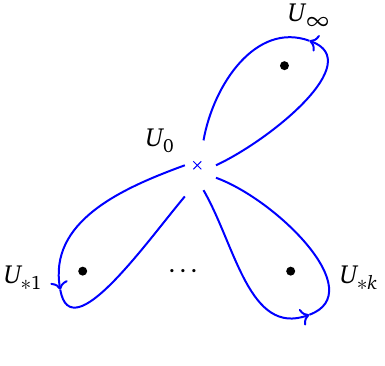
Figure 1: Paths γ generating the fundamental group of the U -plane. The path v around infinity is equal to minus the sum of all the other paths, γ ∞ = − ( γ